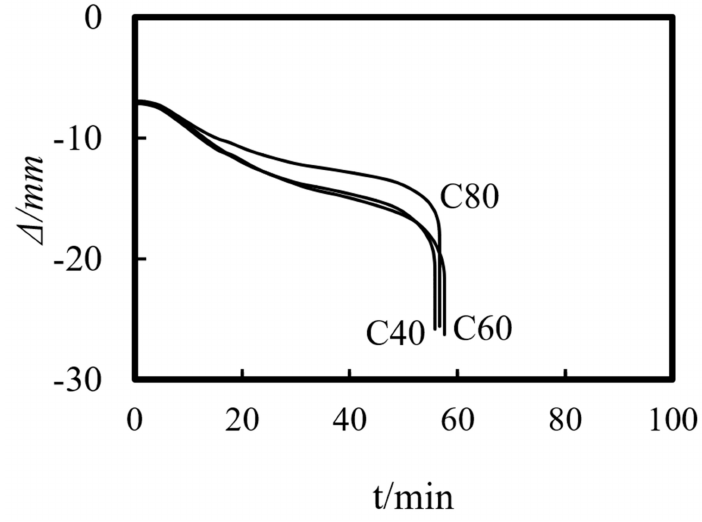
Figure 21. Effect of load eccentricity on the axial deformation − time curve.